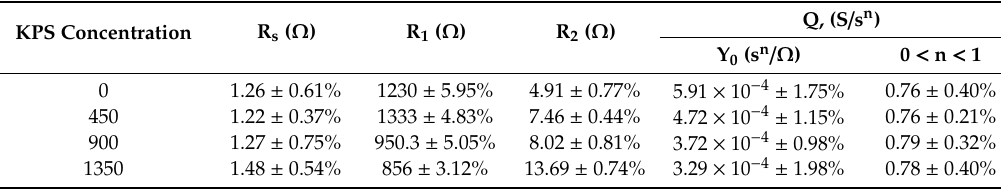
Table 2. Resistance values of Zn anodes in the solution electrolyte containing KPS (450, 900 and 1350 ppm) in 7 M